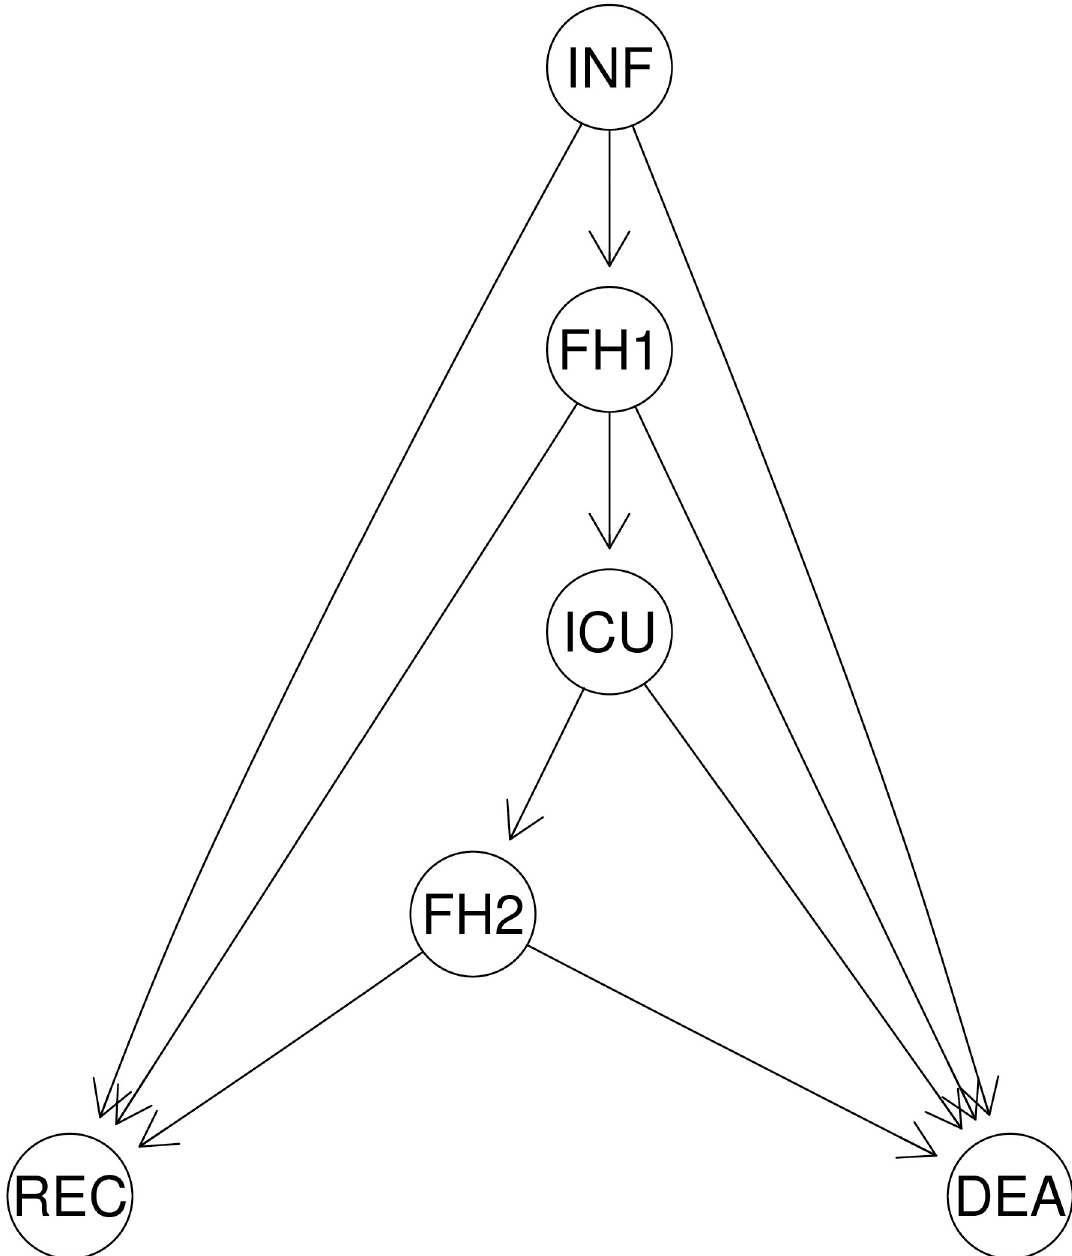
Fig 1. States (INF: Infected, FH1: Floor hospitalisation, ICU: Intensive care unit hospitalisation, FH2: Floor hospitalisation after ICU, DEA: Death due to infection, REC: Recovery from infection) and transitions for the multistate model.